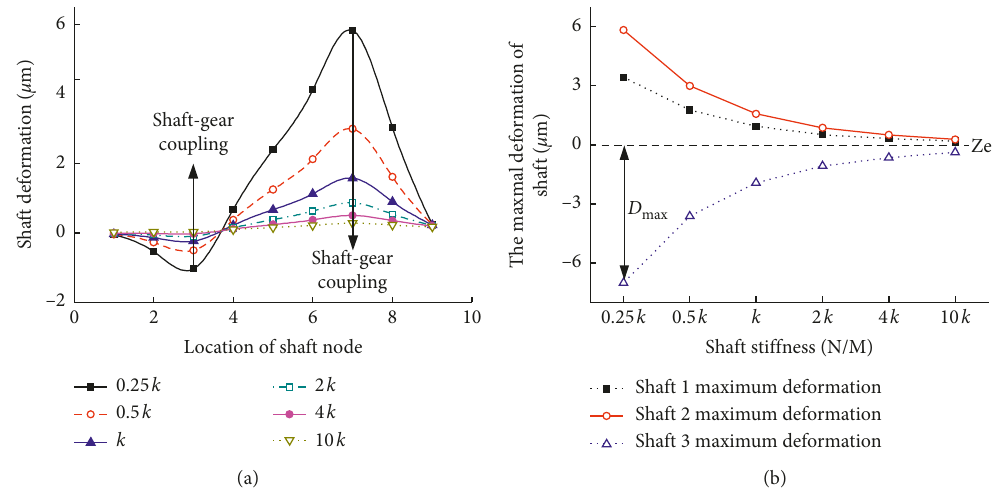
Figure 20: Effect of stiffness of transmission shaft on its static